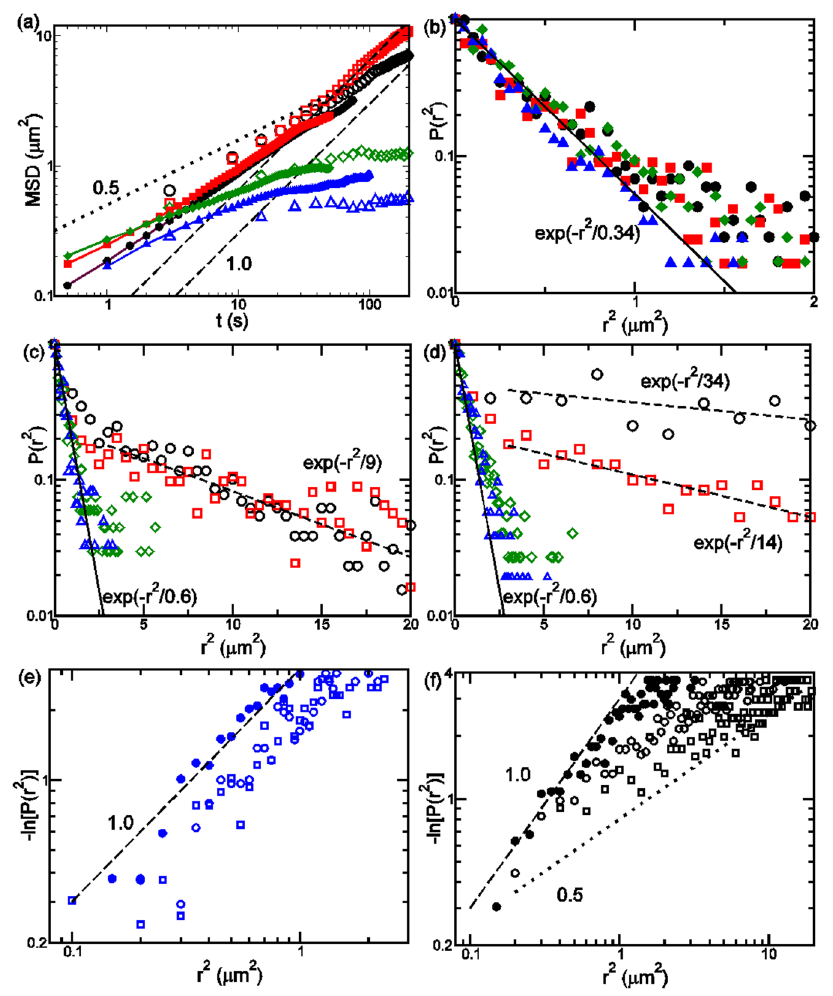
Figure 3. DNA MSD and COM displacement distributions for d = 1.6 (black circles) and 2.2 (red squares), 3.0 (green diamonds), and 3.6 (blue triangles) μ m. ( a ) Short and long-term dynamics exhibited in the MSD. Smaller filled symbols are the short time MSD data for 1.0 (black), 2.0 (red), 3.2 (green), and 3.6 (blue) μ m. The dashed and dotted lines illustrate power law exponents of 1 and 0.5, respectively. ( b – d ) The observed normalized distributions of r 2 for Δ t = 3 ( b ), 300 ( c ), and 1000 ( d ) s. In ( b – d ), the solid and dashed lines are drawn for fits with exp[ − r 2 / λ ]. ( e ) and ( f ) show the log distribution functions for Δ t = 3 (filled circles), 30 (empty circles), and 100 s (squares) for d = 3.6 and 1.6 μ m,